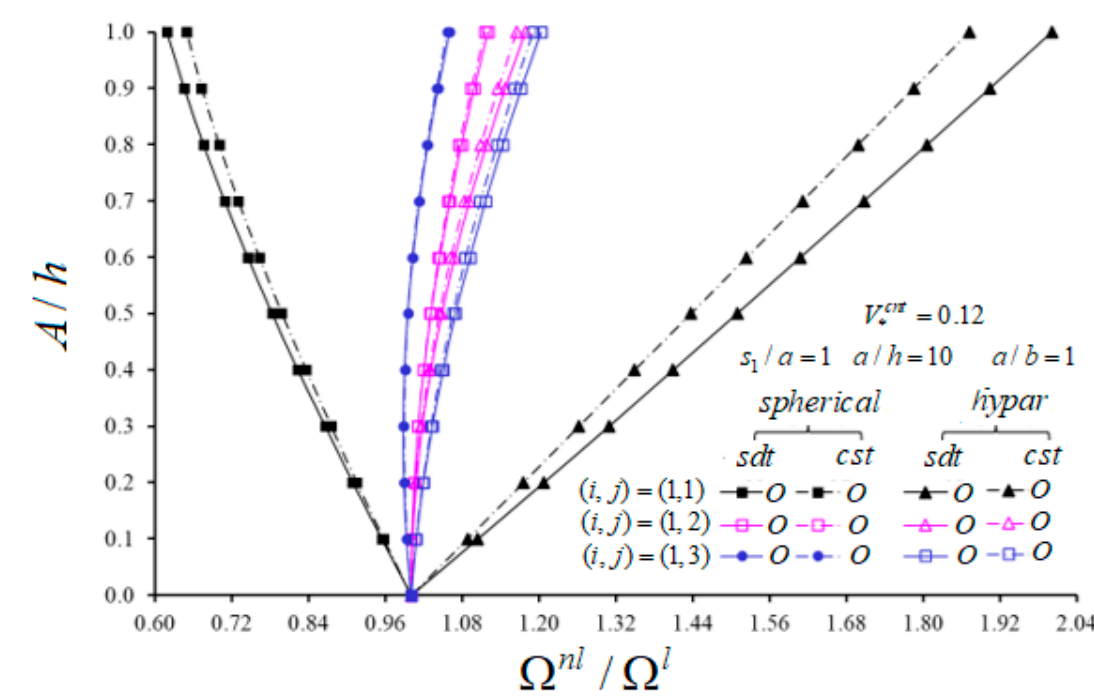
Figure 4. Variation of NLFVs for spherical shell, hypar shell, cylindrical panel and plate patterned by CNTs within CST and SDT against the / A h .